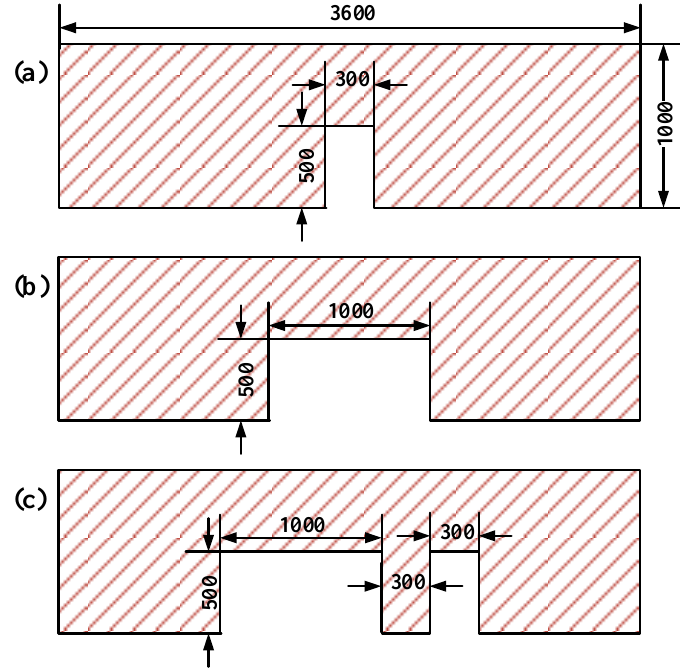
Figure 1. Three feature-scale stamps with different cavities: ( a ) Nanoscale cavity; ( b ) microscale cavity; and ( c ) neighboring micro-and-nanoscale cavities (units: nm). Another 1.2 mm × 1.2 mm patchwork pattern was presented in Figure 2 for a chip-scale study,